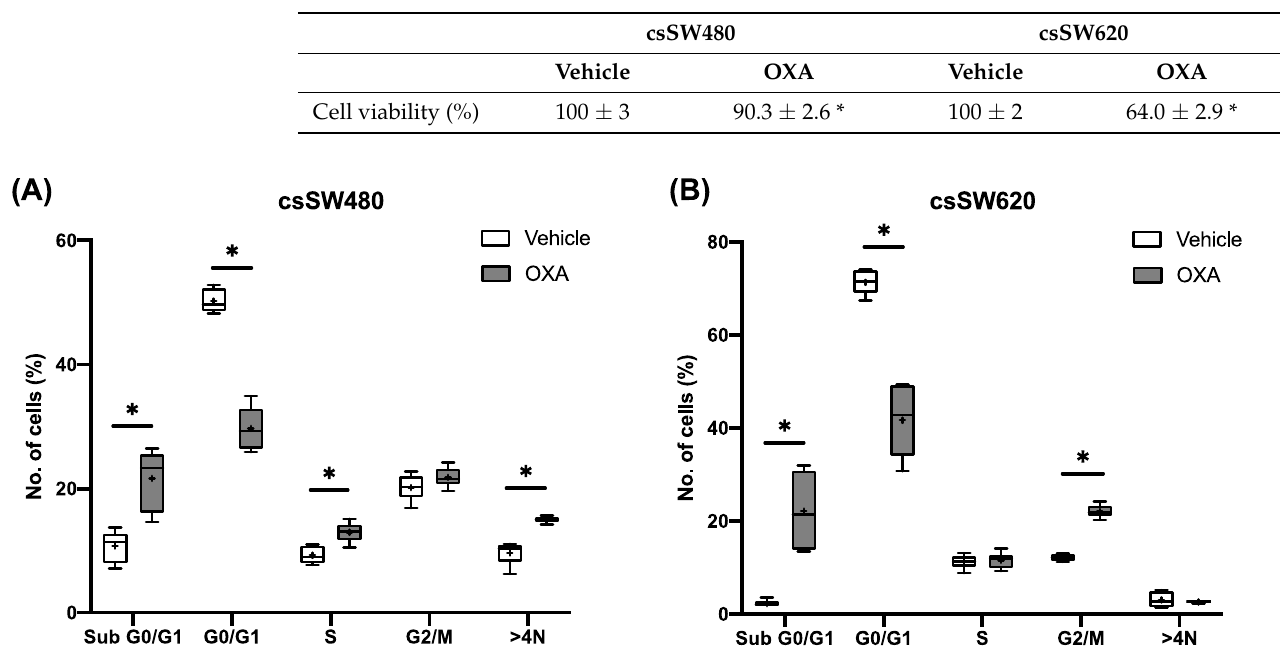
Table 1. Oxaliplatin effect on cell viability in SW480 and SW620 tumourspheres. CRC cell lines were treated 96 h with vehicle (0.1% DMSO) or 5 µ M oxaliplatin. Data represent means ± SD ( n ≥ 4). Student’s test or Mann—Whitney test were performed to find determine significance between the experimental groups. Statistical significance was set at * p < 0.05.